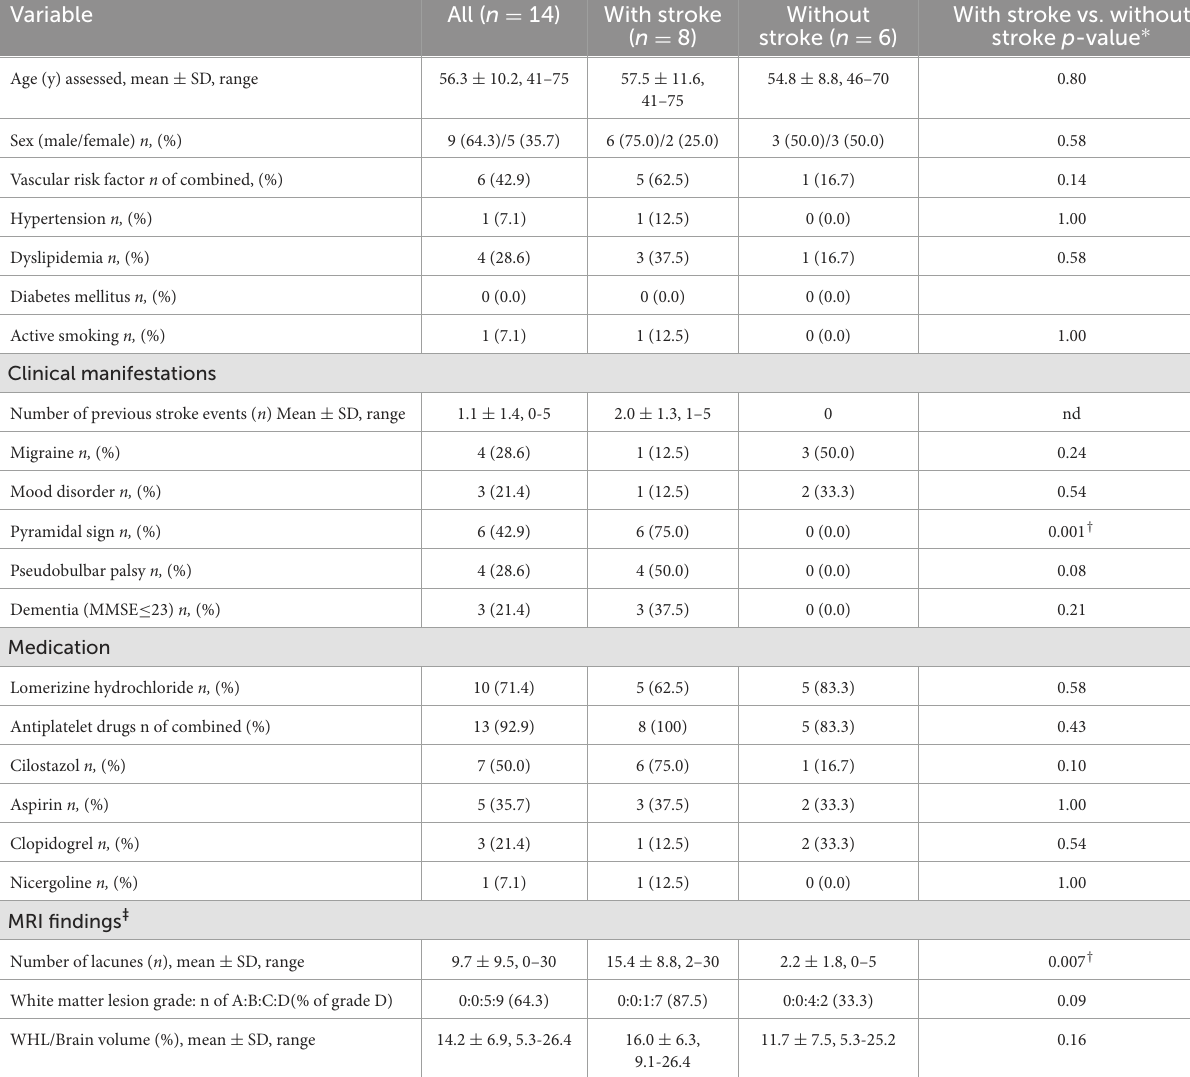
TABLE 1 Comparison of the baseline characteristics and MRI findings between patients with and without stroke. Variable All ( n = 14) With stroke